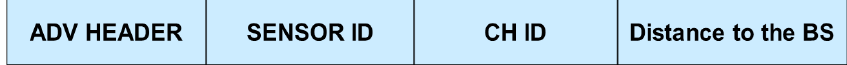
Figure 9. Advertisement message (ADV) of cluster header (CH).